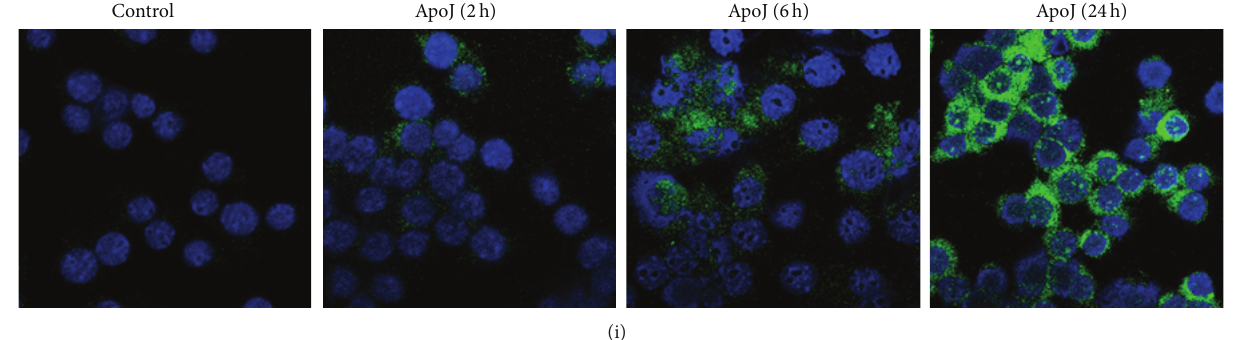
Figure 1: Apoptotic cells induce COX-2 expression by RAW 264.7 cells. RAW 264.7 cells were stimulated by UV-exposed apoptotic (ApoJ) or viable (ViaJ) cells of Jurkat T cells (a, b, f, g, i); UV-exposed (ApoN) or aged apoptotic (AgeN) or viable cells of neutrophils (c); UV-exposed apoptotic or viable cells of HeLa cells (ApoH, ViaH) (d); UV-exposed apoptotic or viable cells of thymocytes (ApoT, ViaT) (e) for the time indicated. (a–e)COX-2orCOX-1mRNAlevelswereanalyzedbysemiquantitativeRT-PCRandnormalizedto 𝛽 -actinmRNAlevels. (c)COX- 2 mRNA levels were normalized to 𝛽 -actin mRNA levels after standardization of the amount of ApoN and AgeN cells. (f–h) Immunoblots with anti-COX-2 or COX-1 antibodies were performed using cultured cell lysates. Relative values of COX-2 or COX-1 expression are indicated below the bands. (h) RAW cells were pretreated with 10 𝜇 g/mL actinomycin D (AcD) or 10 𝜇 g/mL cycloheximide (CHX) for 1 h before stimulation with ApoJ. Values represent mean ± SEM of three or more separate experiments; ∗ 𝑃 < 0.05 . (i) Immunofluorescence staining ( green ) for COX-2 in RAW cells. Images were captured at × 800 magnification. Representative results from three separate experiments are